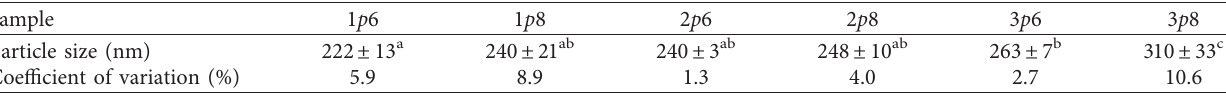
Means with different superscript letters are significantly different ( p < 0 . 05).